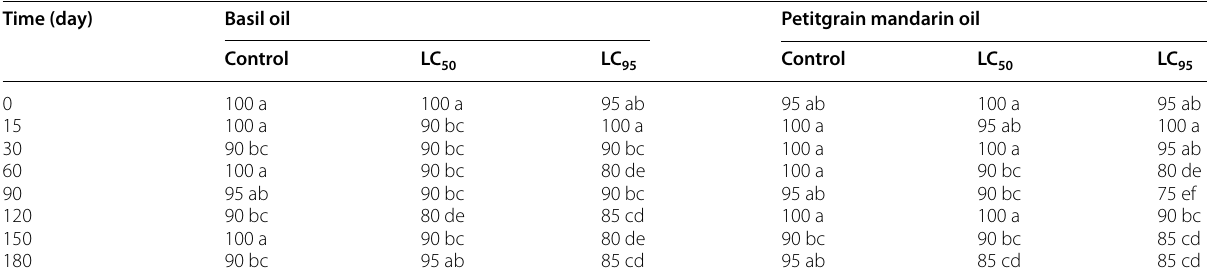
In the same column, means followed by the same letter are not significantly different at 0.05 level according to Duncan multiple range test